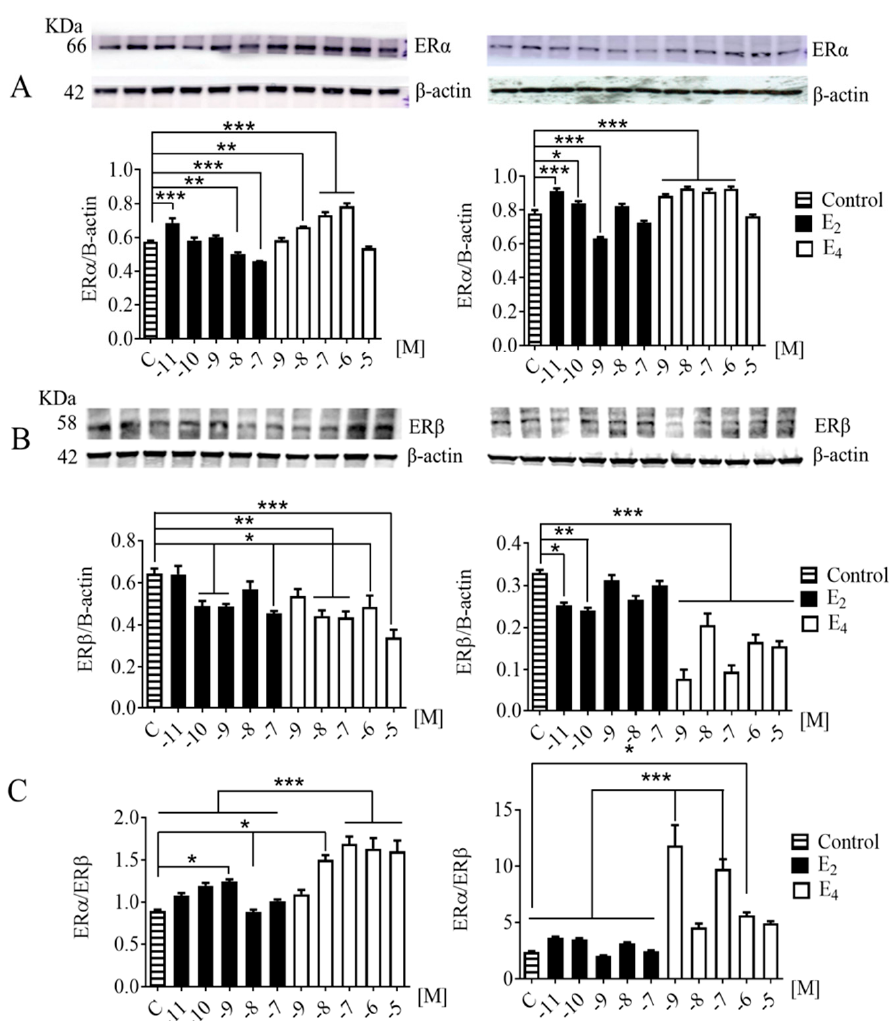
Figure 2. ERs protein levels measurement by Western blot after E2 or E4 treatments in endometriotic cells. ( A ) ER α levels over β -actin levels (AU) for 11Z cells (left) and Hs832 (right). ( B ) ER β levels over β -actin levels (AU) for 11Z cells (left) and Hs832 (right). ( C ) ER α / ER β rate values for 11Z cells (left) and Hs832 cells (right). ( n = 3), * p < 0.05, ** p < 0.01, *** p < 0.001, by one-way ANOVA along